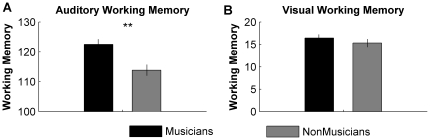
Performance for musicians and non-musicians on working memory tasks.Musicians demonstrated significantly better auditory working memory than non-musicians, but no enhancement for visual working memory. Error bars represent one standard error. ** p<0.01.